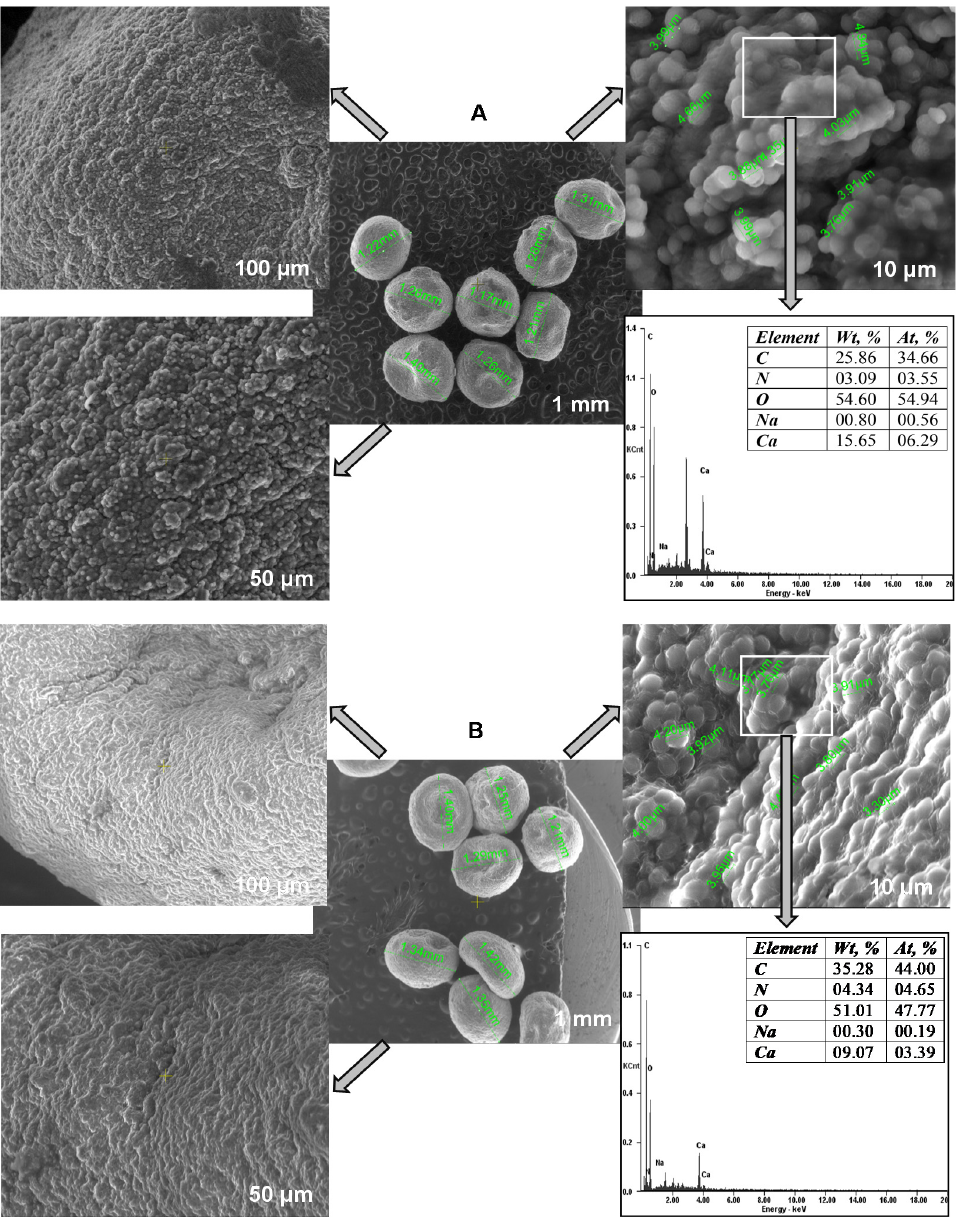
Figure 4. SEM images and EDAX analyses of the biosorbent before ( A ) and after biosorption ( B ).